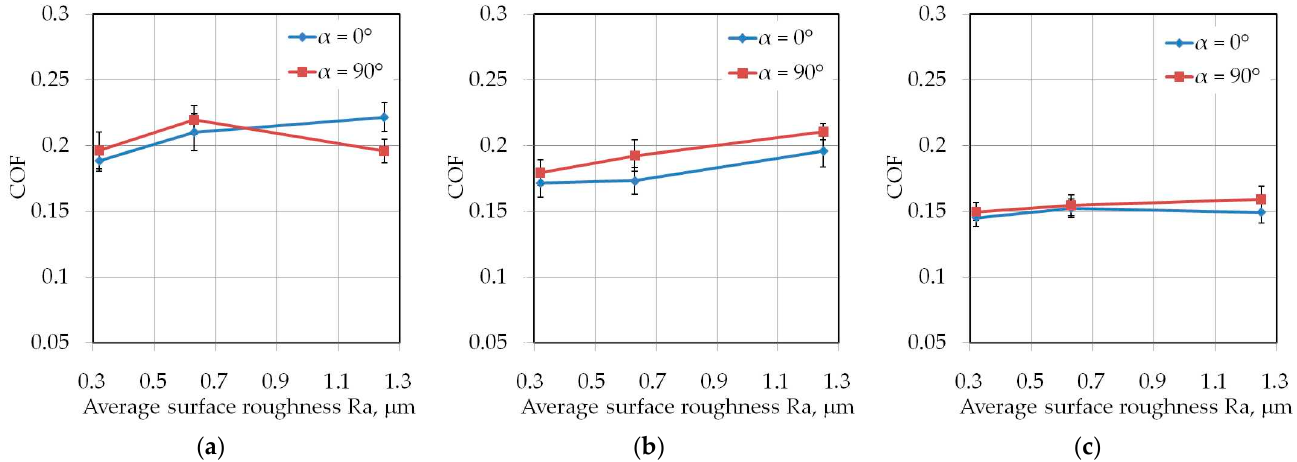
Figure 14. The effect of the sample orientation on the value of COF for specimens with a width of 14 mm tested at LAN-46 oil lubrication conditions: ( a ) h = 6 mm, ( b ) h = 12 mm, ( c ) h = 18 mm.